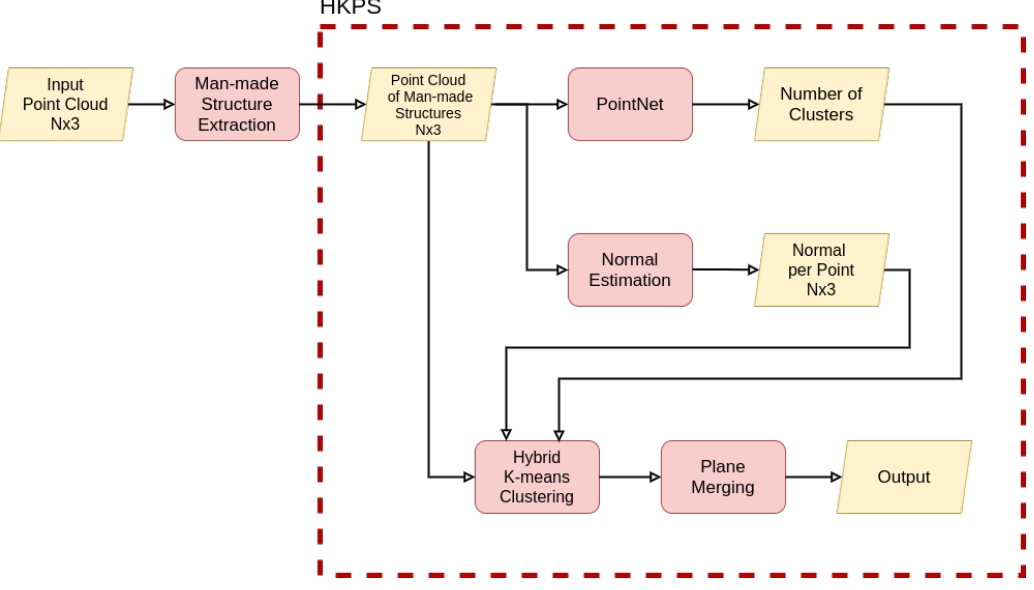
Figure 2. An overview of the proposed framework. PointNet [6] takes the input point cloud of man-made structure and outputs the number of clusters. We estimate the normal of each point, and then perform hybrid K-means clustering for plane segmentation (Sections 3.1 and 3.2). At the end of the network architecture, the plane merging process optimizes the number of planes (Section